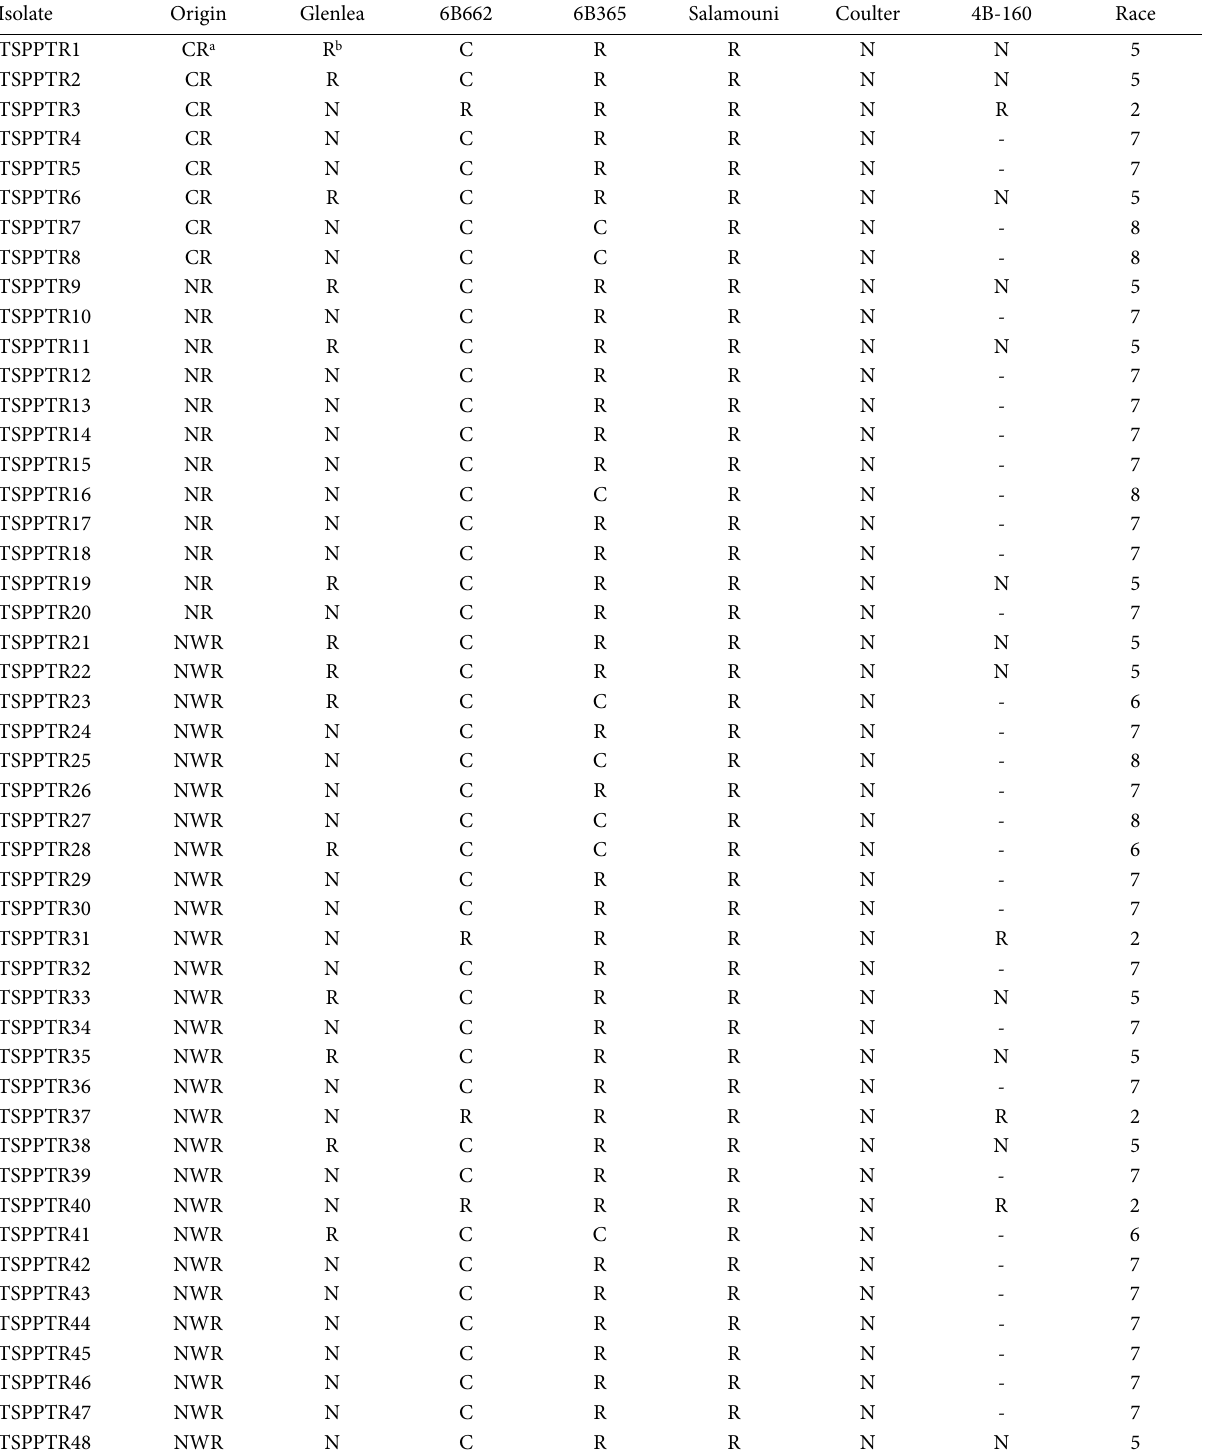
Table 3. Reactions of six differential wheat lines to 84 isolates of Pyrenophora tritici-repentis , their regional origin and race designation.